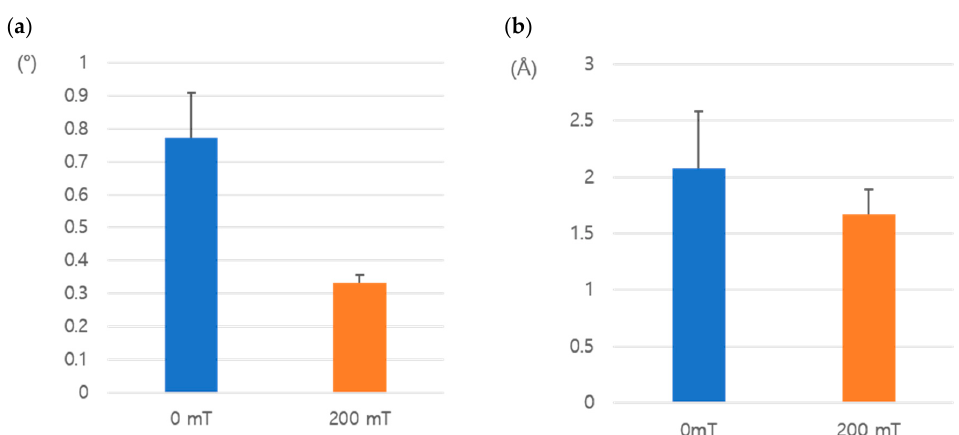
Figure 7. Comparison of the mosaicity and resolution of HEWL: ( a ) mosaicity; ( b ) resolution. The number of collected data sets of crystals grown under 0 and 200 mT are 20 and 20, respectively.